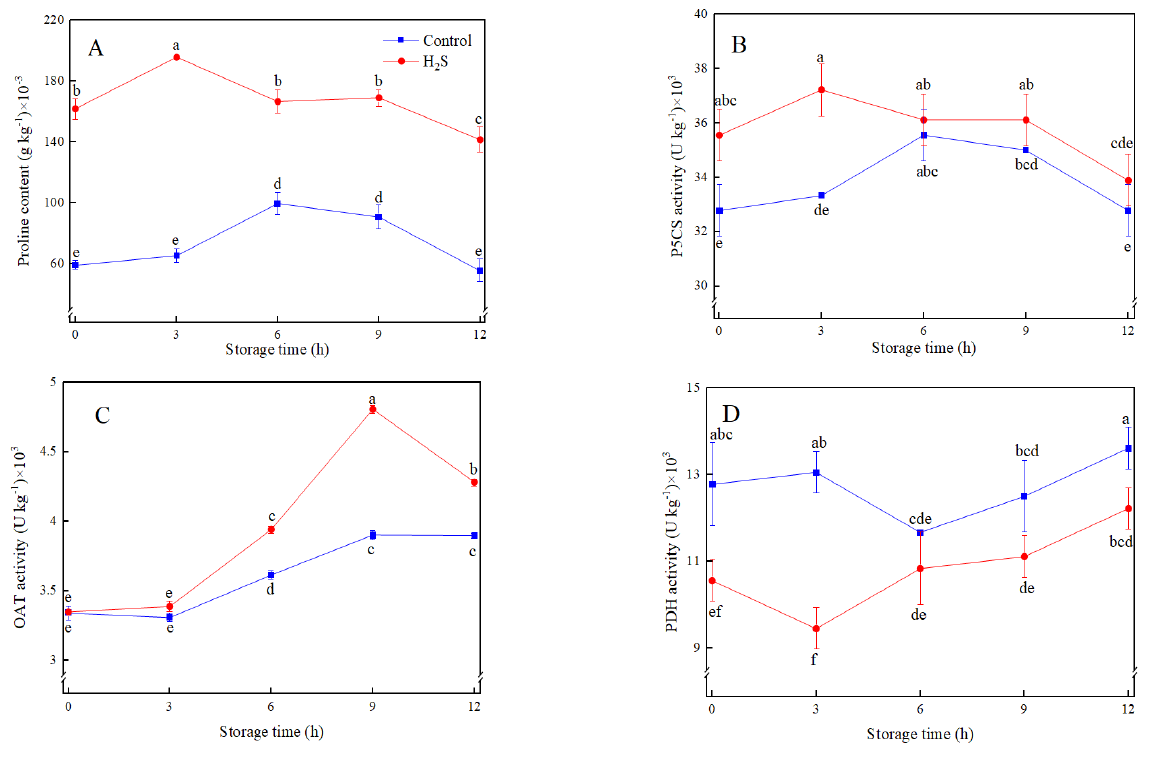
Figure 4. Effects of H 2 S treatment on proline content ( A ) and the activities of P5CS ( B ), OAT ( C ), and PDH ( D ) of fresh-cut peaches during storage. Data are presented as mean ± standard errors of triplicate samples. Different letters indicate statistically significant ( p < 0.05)